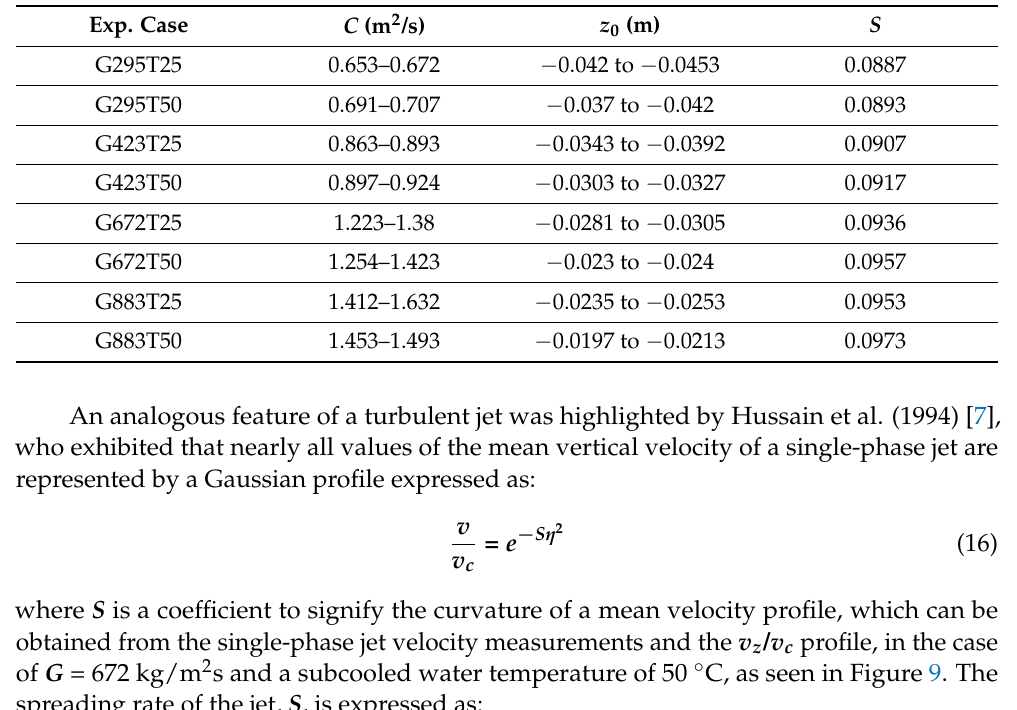
Figure 8. Centerline velocity along the height from the condensation point. Table 4. Turbulent flow self-similarity parameters.